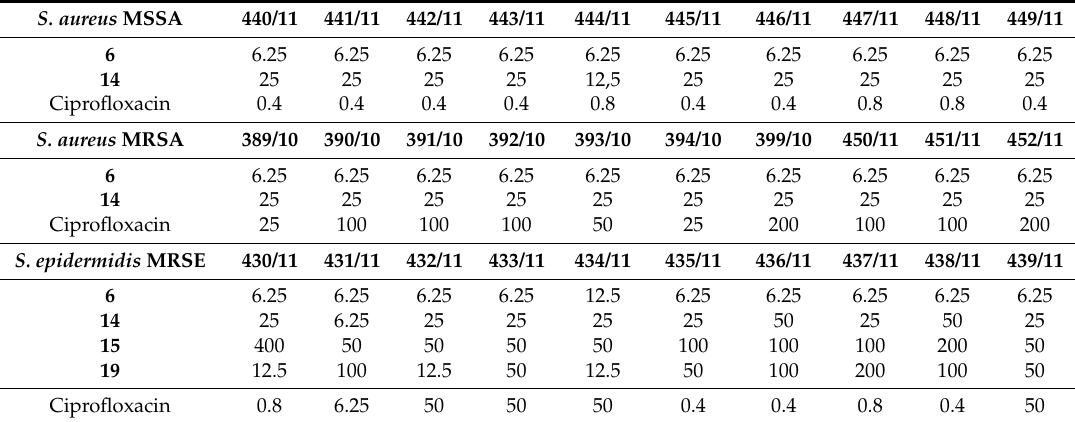
Table 3. Activity of compounds against hospital methicillin-susceptible strains of S. aureus (MSSA), methicillin-resistant strains of S. aureus (MRSA) and S. epidermidis (MRSE)—minimal inhibitory concentrations (MIC, µ g/mL).